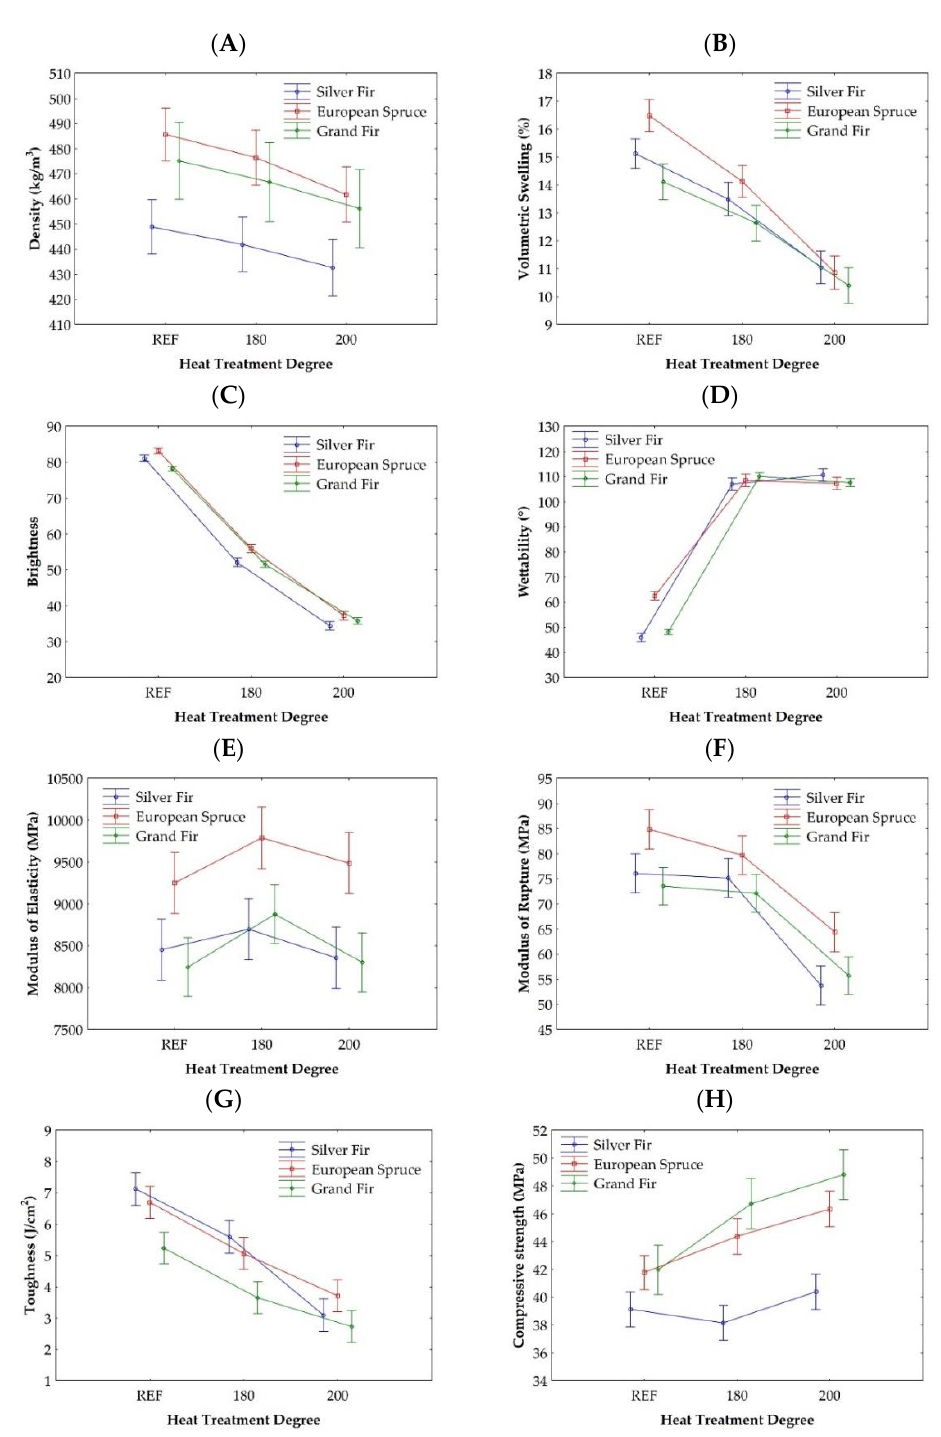
Figure 2. Effect of heat treatment on ( A ) wood density, ( B ) volumetric swelling, ( C ) brightness, ( D ) wettability, ( E ) modulus of elasticity, ( F ) modulus of rupture, ( G ) toughness, ( H ) compressive strength. ANOVA analysis output. REF indicates test samples without heat treatment.